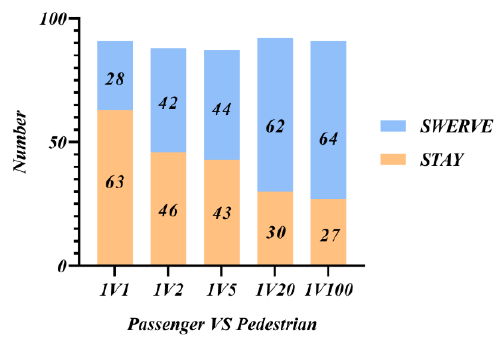
Figure 3. Participants’ future preference choice.